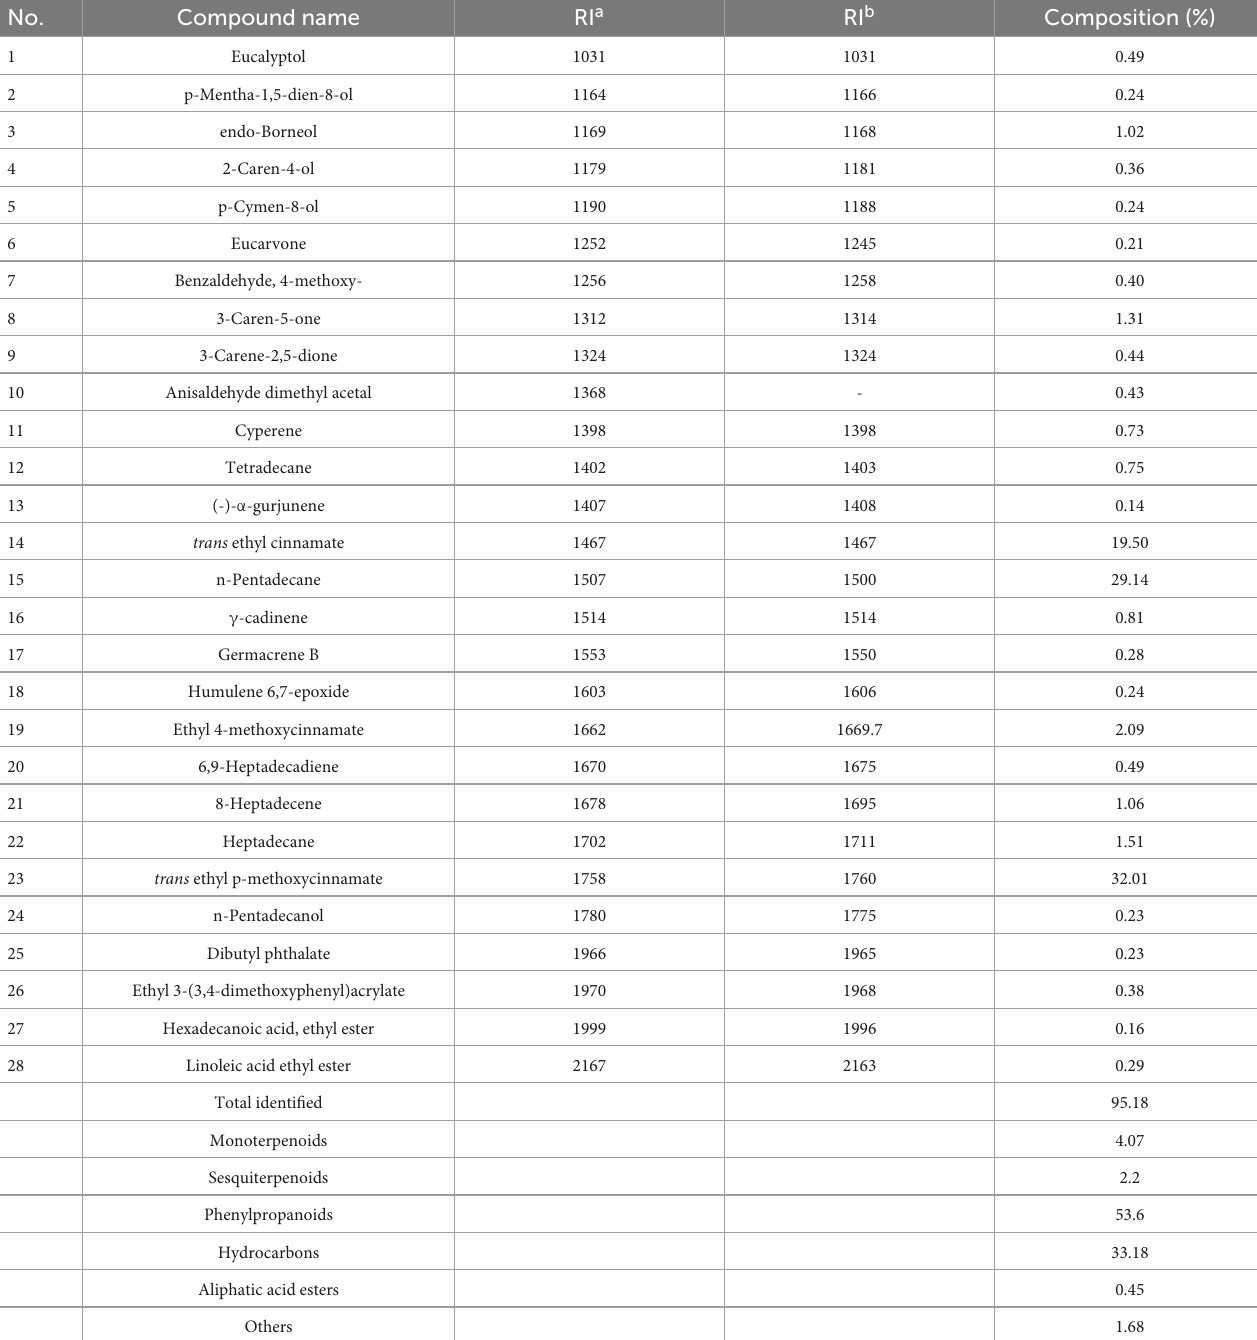
TABLE 1 Chemical composition of the K. galanga essential oil.